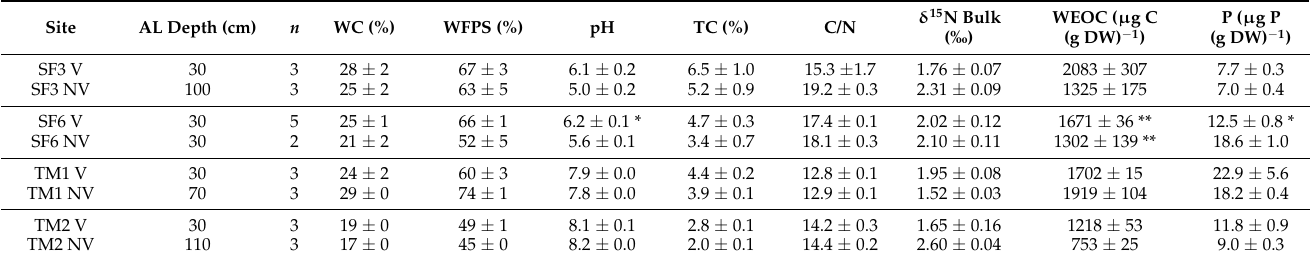
Table 1. Active layer (AL) depth and soil properties (water content (WC), water-filled pore space (WFPS), soil pH (pH), total carbon (TC), total carbon–nitrogen ratio (C/N), delta 15 N in bulk soil ( δ 15 N), water–extractable organic carbon (WEOC), and phosphorus (P)) of sampled revegetated (V) and non-vegetated (NV) slump floor (SF) and thaw mounds (TM) soils ( n = number of